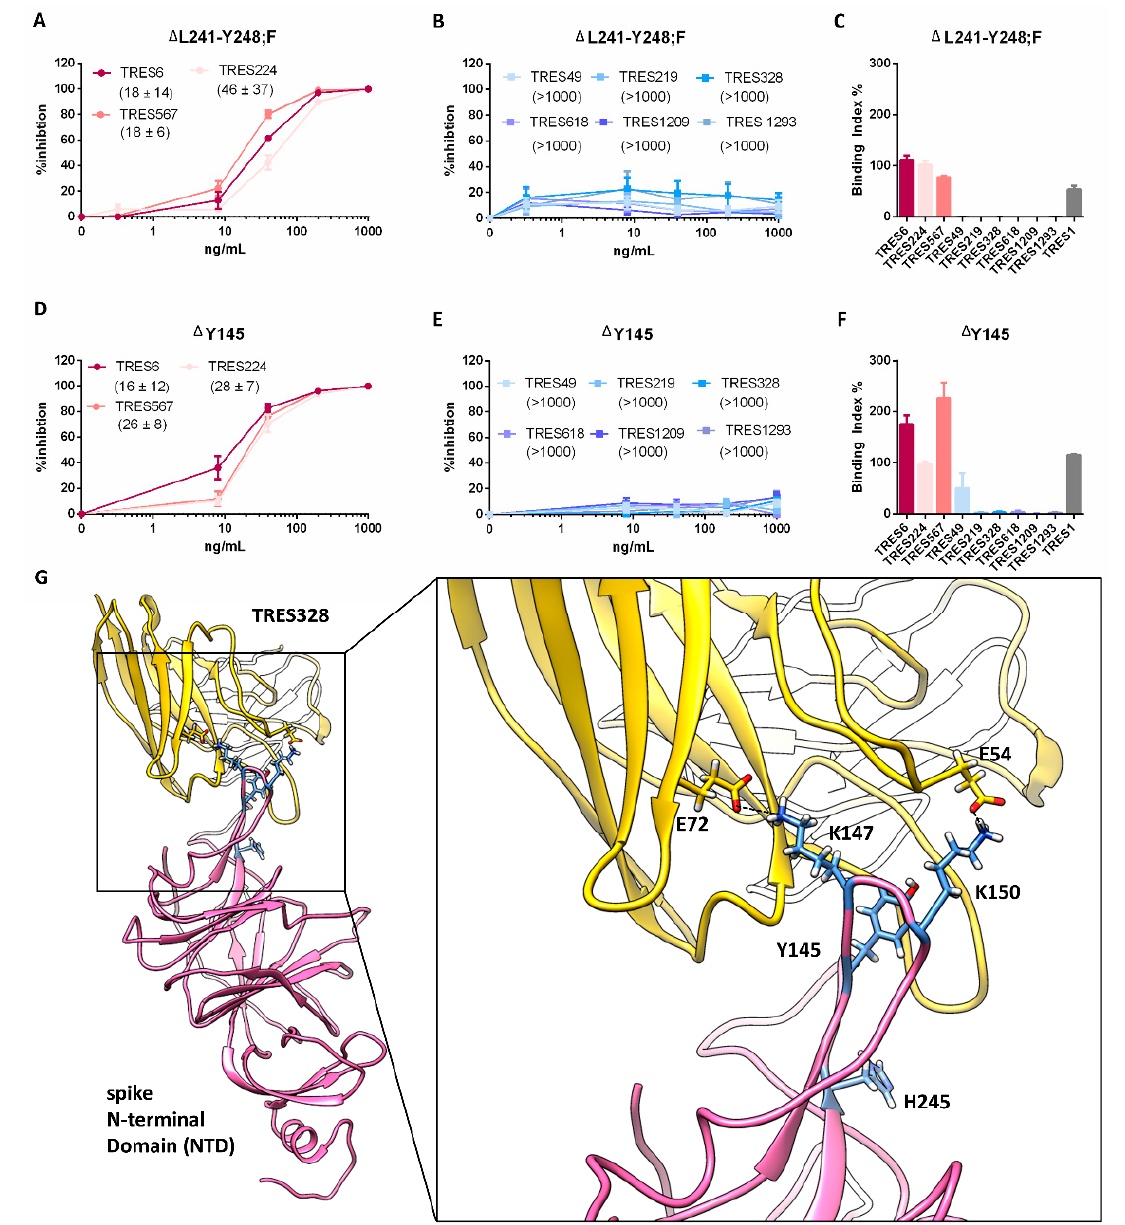
Figure 3. Characterization of S of TRES328 escape variants. ( A , B , D , E ) Percent inhibition of lentiviral vector particles pseudotyped with SARS-CoV-2 S carrying the indicated RBD and/or NTD mutations. IC50s of the indicated RBD (red) and NTD (blue) cluster antibodies are shown in brackets in ng/mL. ( C , F ) Binding of the RBD (red) and NTD (blue) cluster antibodies and a S2 binding antibody (grey) to S with the indicated mutations. Neutralization and binding of the D614G wild-type spike protein is given in Figure 5A–C. ( G ) Structural modeling of TRES328 (yellow) in complex with the NTD of wild-type spike protein (pink). NTD residues are represented as blue sticks and TRES328 residues as yellow sticks in order to highlight the position of Y145 and H245 or to illustrate the stabilizing electrostatic interactions (black dashed lines) between K147 and E72 of TRES328 and K150 and E54 of TRES328, respectively.